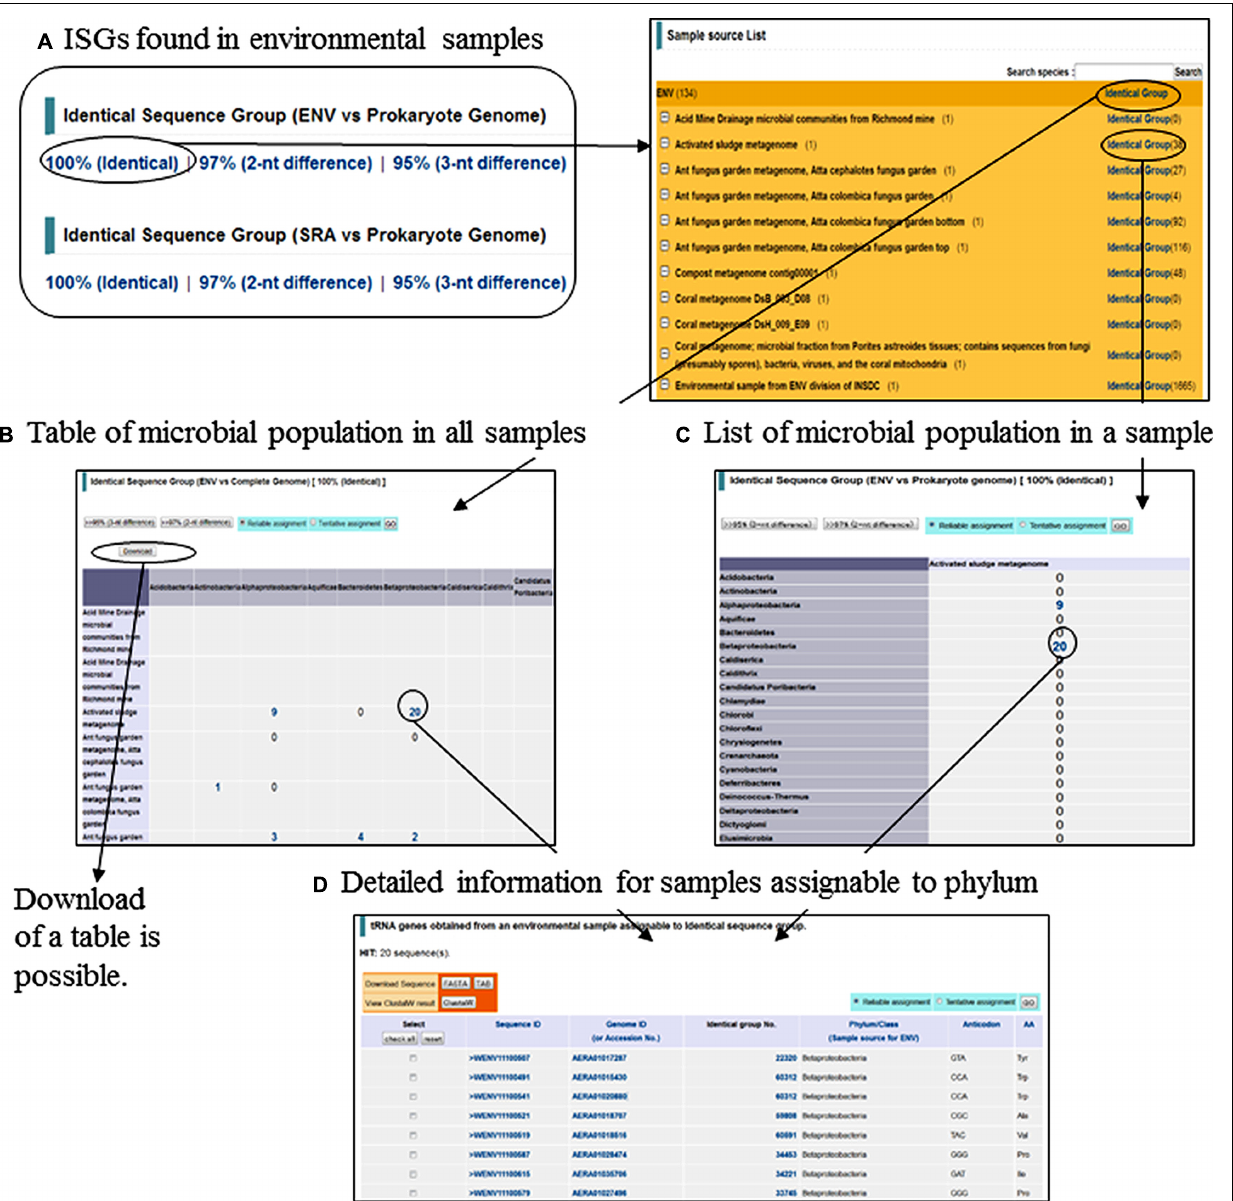
FIGURE 2 | List and search for (A) Identical sequence groups (ISGs) found in environmental samples, (B)Table of microbial population in all samples, (C) List of microbial population in a sample, and (D) Detailed information for samples assignable to